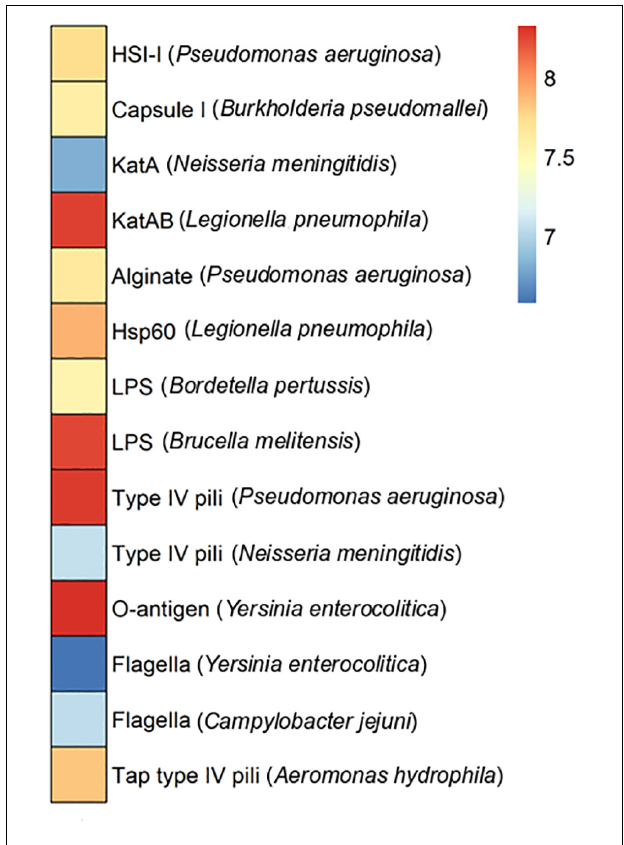
FIGURE 5 | Virulence factors in the plasmidome of Puquio de Campo Naranja. The color scale indicates the abundance of each virulence factor in FPKM (fragments per kilobase per million). Values are plotted on a logarithmic scale. Pathogenic bacteria are specified in